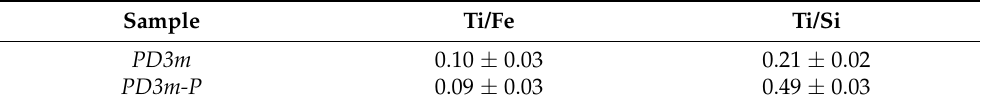
Table 3. Ti/Fe and Ti/Si atomic concentration ratios obtained by EDS of the PD3m and PD3m-P coatings.